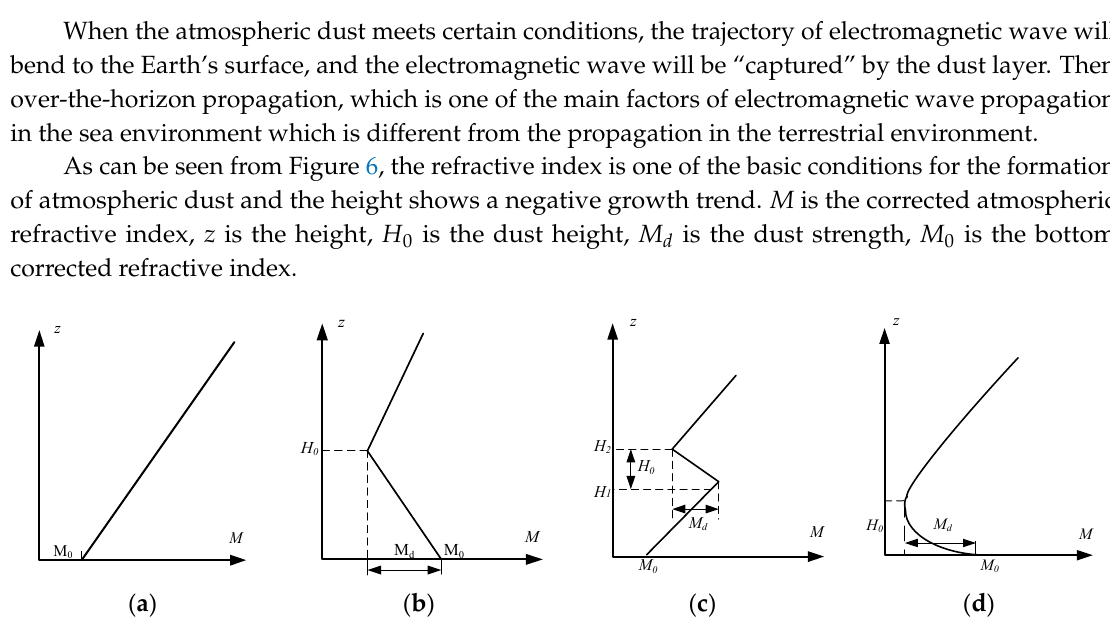
Figure 6. Refractive index profiles of several common atmospheric dust types: ( a ) is the refractive index profile of the standard atmosphere; ( b ) is the refractive index profile of surface dust; ( c ) is the refractive index profile of suspended dust; and ( d ) is the refractive index profile of evaporation